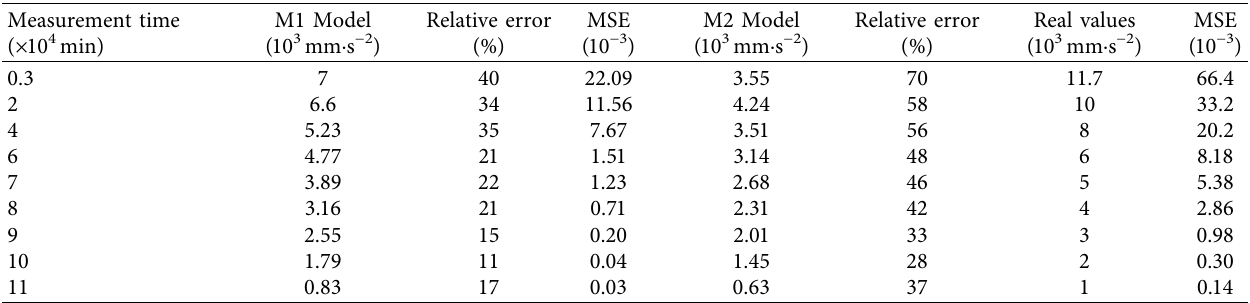
Table 5: Error analysis of RUL estimation value of the M1model and M2